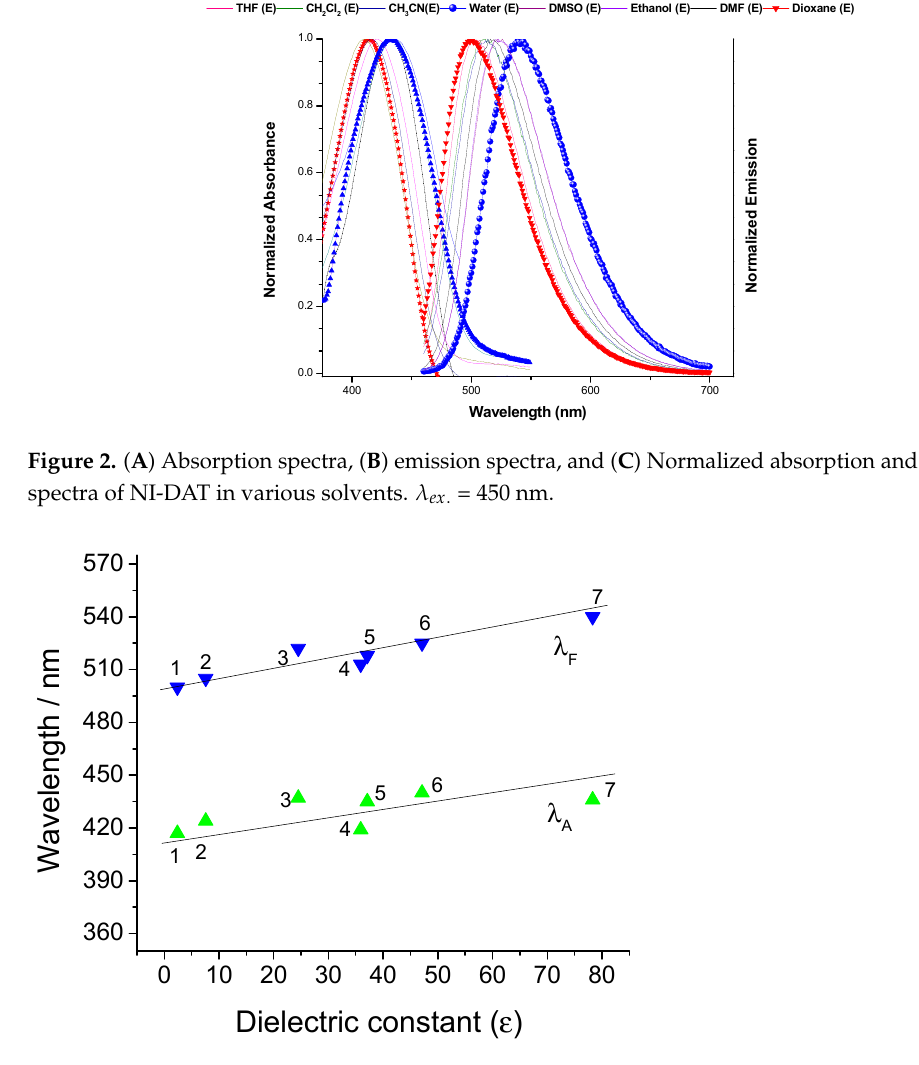
Figure 3. Dependence of absorption (green triangles) and fluorescence (blue triangles) maxima of NI-DAT on the dielectric constant: 1—Dioxane; 2—Tetrahydrofuran; 3—Ethanol; 4—Acetonitrile; 5—N,N-dimethylformamide; 6—Dimethyl sulfoxide; 7—Water.